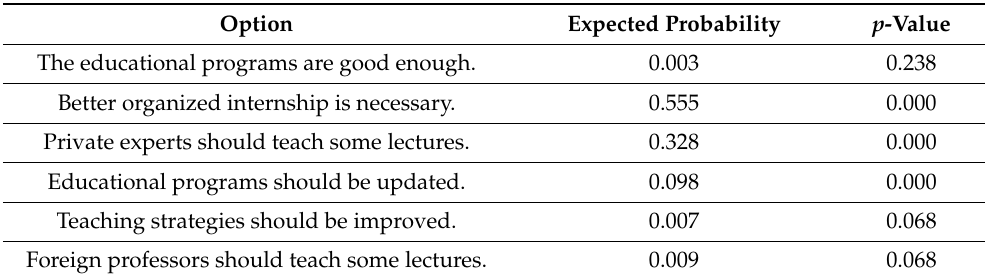
Table 4. Students’ probabilities of ranking a certain option that is considered significant by the manager